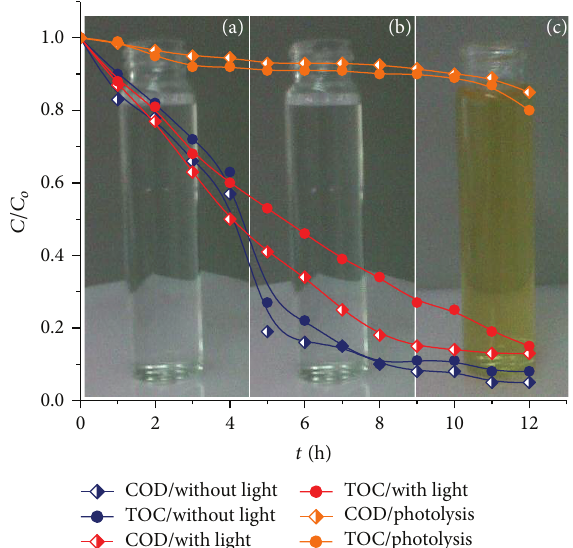
Figure 7: Evaluation of the use of UV light ( 𝜆 = 254 nm). Removal of COD and TOC in spent caustic corresponding to the simple sample using Ti/BDD, applying 0.96 A ( 𝑗 = 0.32 Acm −2 ), under constant stirring, pH 1 (adjustment with H 2 SO 4 ) and 𝑡 𝑟 = 12 h. Images of (a) in the absence of UV light, (b) in the presence of UV light ( 𝜆 = 254 nm), and (c)